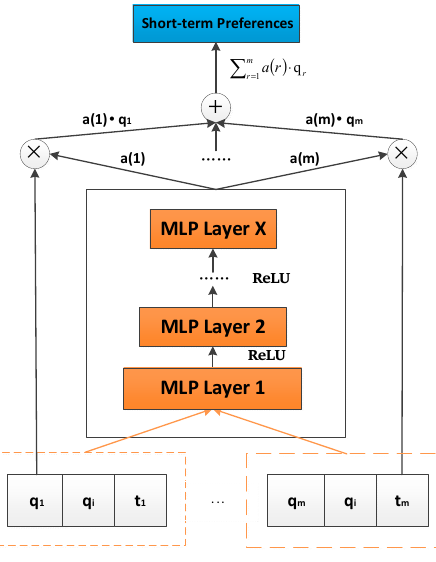
Figure 2. The architecture of the attention network.